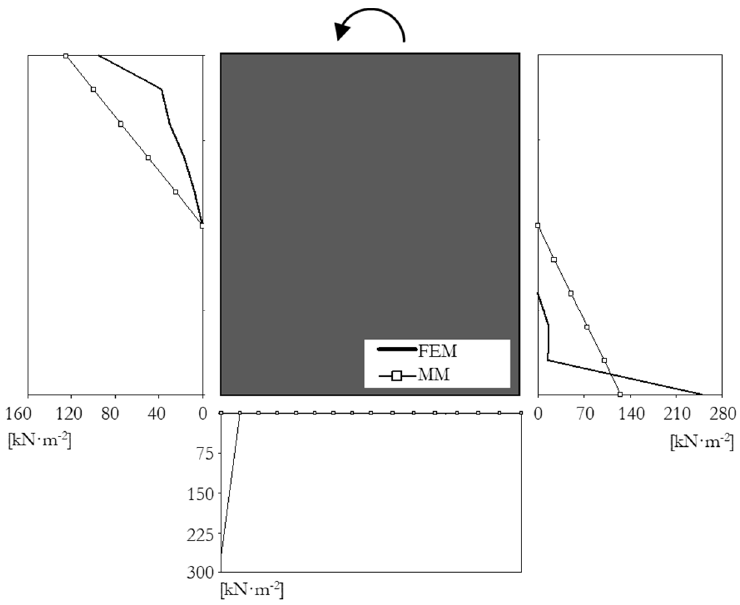
Figure 25. Pressure in the plane of symmetry, expressed in kN · m − 2 and determined by the Finite Element Model and the Matrix Model, on the walls and base of the footing due to a 5.53 kN · m moment load.